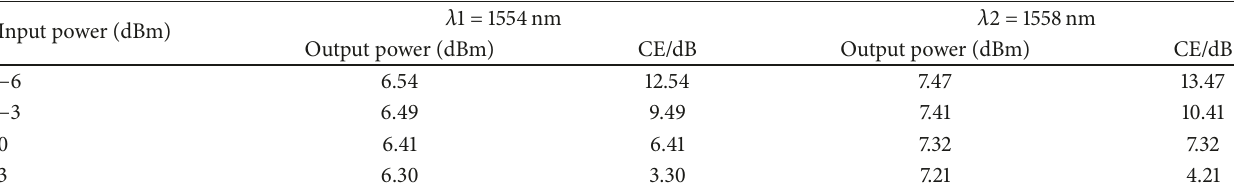
Table 3: Conversion efficiency